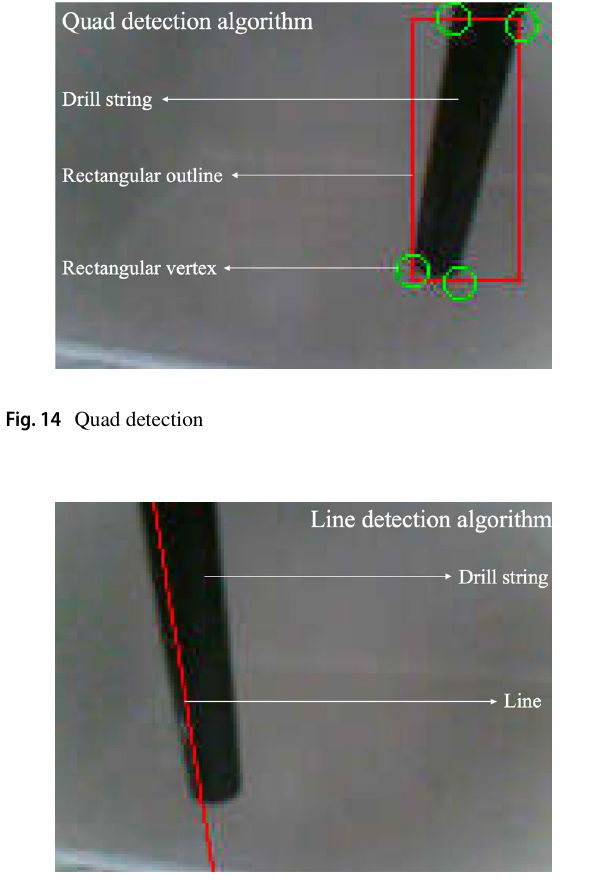
Fig. 17 Linear regression detection